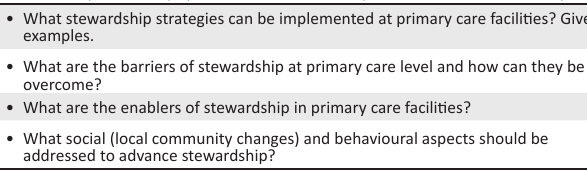
Source : Photos taken by Renier Coetzee. FIGURE 2: Participants engaging in a discussion at the antimicrobial stewardship